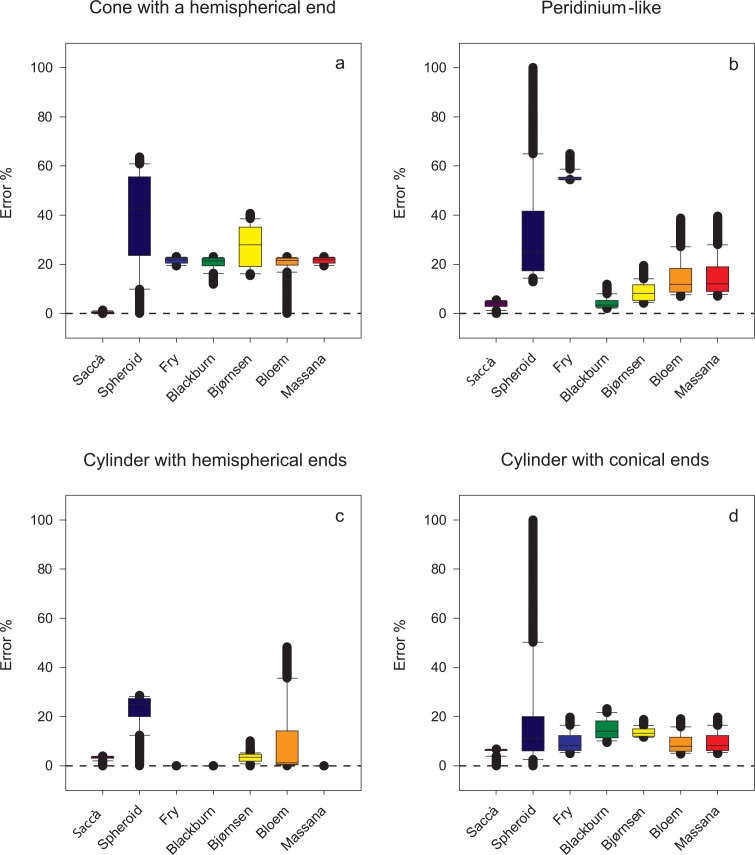
Box plots showing the errors caused by the new equation and the other tested methods in the estimation of the volume of four of the eight simple or composite geometric shapes (those yielding variable errors with the new equation and the prolate spheroid equation).The median, as well as the 10th, 25th, 75th, and 90th percentiles are shown. Whiskers indicate the 10th percentile and 90th percentile, respectively; while the extent of outlying points (solid circles) identifies the data range (standard method is used to calculate percentile values).